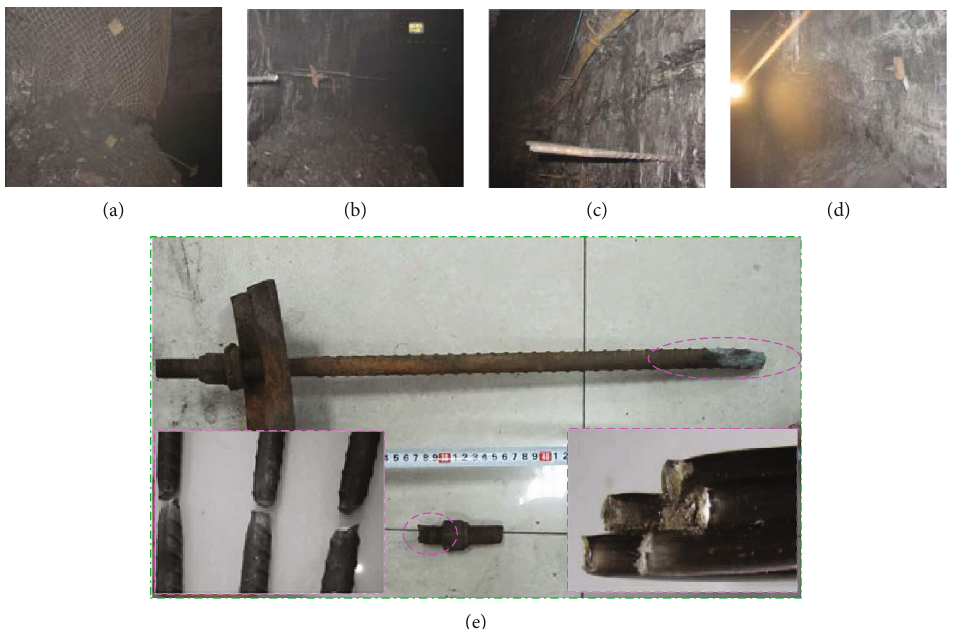
Figure 1: Typical failure cases of roadways supported by rock bolts and the broken rock bolt in a coal